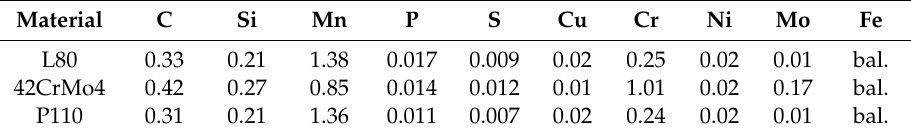
Table 1. Chemical composition of the investigated materials